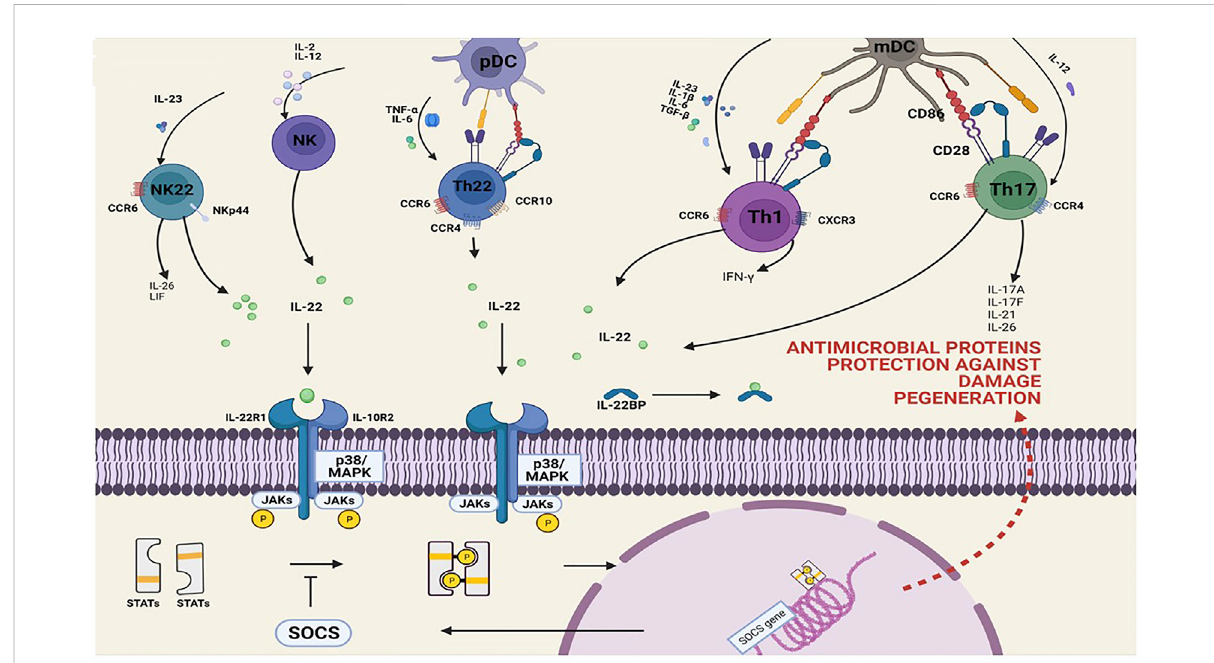
FIGURE 2 Overview of the production and action signaling pathways of IL-22. IL-22 is often, but not always, correlated with IL-17 expression. Subpopulations of CD4 + T cells, CD8 + T cells, innate T cells, and innate lymphoid cells are sources of IL-22, IL-22, and IL-17 or IL-17. The main cytokines drivingIL-22 expression are IL-23, IL-6, and IL-1 β . Certain cell types requireIL-12, IL-18, IL-21, and TNF- α to produce IL-22. TGF- β inhibits IL-22 production in all T-cell subsets but induces IL-17 in these cells; IL-22 signals through its cognate receptor/JAK complex, resulting in downstream phosphorylation of STAT (homo- or heterodimer). Translocation of these STAT complexes to the nucleus drives transcription of genes involved in processes ranging from in fl ammation to angiogenesis and survival. The control of activity of this pathway involves different mechanisms including regulation of the phosphorylation state of JAK and STAT by phosphatases, or of the JAK kinase activity by SOCS (suppressor of cytokine signaling), for